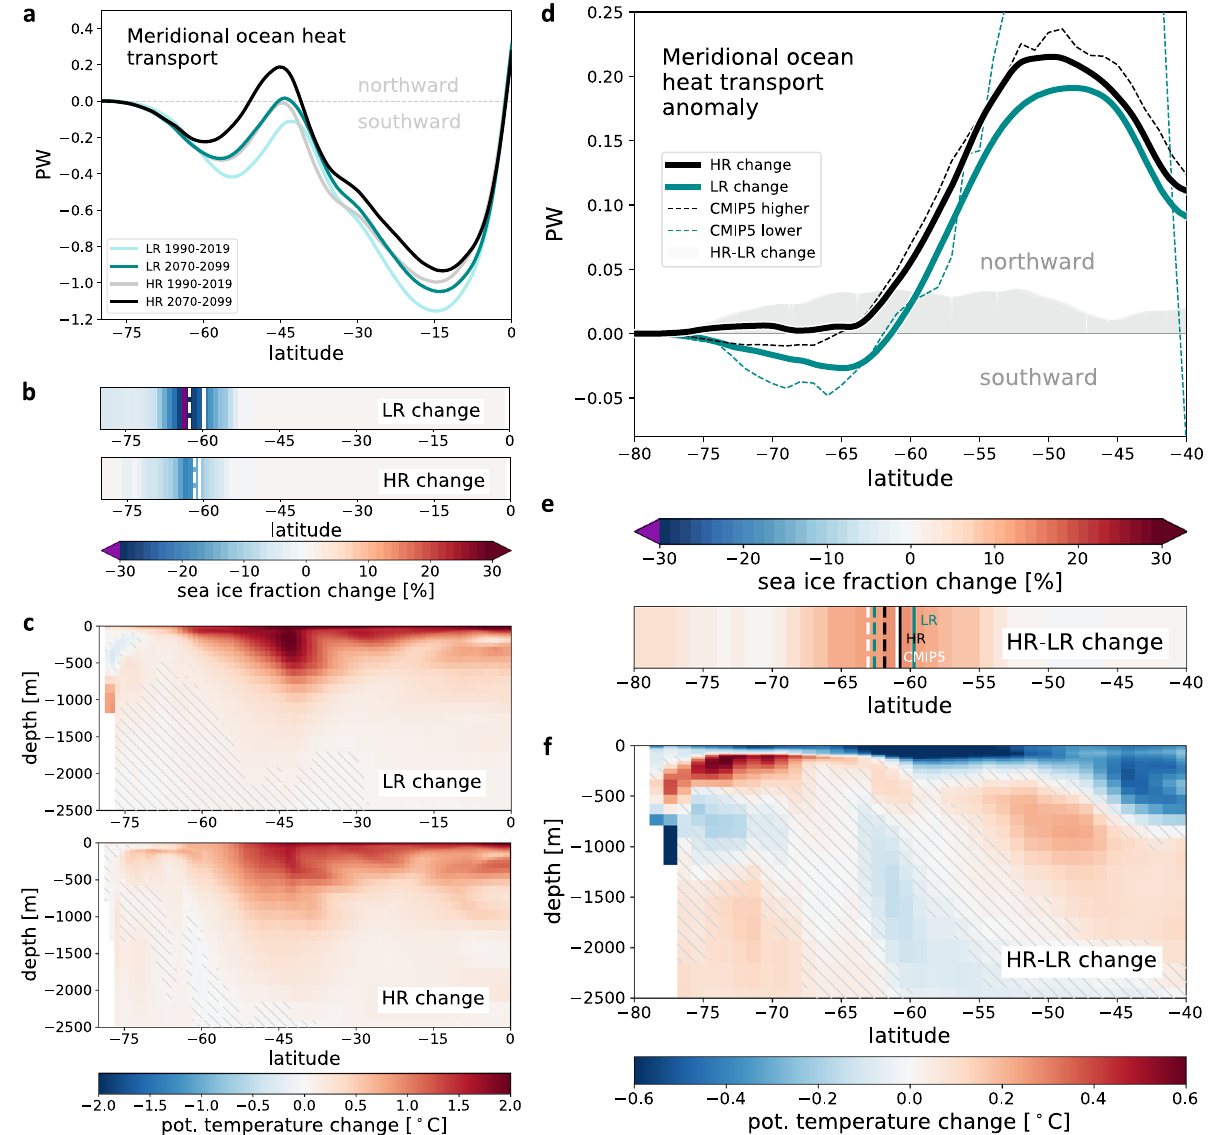
Fig. 5 Meridional ocean heat transport MHT [1 PW = 10 15 W] in the Southern Hemisphere and its link to zonal-mean potential temperature [°C] and zonal-mean sea-ice changes [%]. a MHT in the low-resolution (LR) and high-resolution (HR) experiment for 1990 – 2019 (light green/grey) and 2070 – 2099 (dark green/black). b Zonal-mean sea-ice change and c zonal-mean ocean potential temperature change in LR and HR between 1990 – 2019 and 2070 – 2099. Vertical solid lines in panel ( b ) give the location of the September sea-ice edge in 1990 – 2019, vertical dashed lines the location in 2070 – 2099. d Zoom (40 – 80° S) into the anomalous MHT (2070 – 2099 minus 1990 – 2019). Climate models participating in the Coupled Model Intercomparison Project (CMIP5) are grouped into two sets with ‘ higher ’ / ‘ lower ’ resolution than 90 km (for the computation, see “ Methods ” ). e Difference in the response (HR-LR) of the panels in ( b ). Vertical solid (dashed) lines denote the location of the September sea-ice edge in 1990 – 2019 (2070 – 2099) in LR, HR, and in CMIP5 ( “ Methods ” ). f Difference in the response (HR-LR) of the panels in ( c ). The signals are signi fi cantly larger than typical unforced running 30yr-variability (standard deviation) of zonal-mean potential temperature in the 1950 control simulations. Hatching indicates non-signi fi cant regions where the signals and difference in the response are smaller than two standard deviations (see “ Methods ” ). The “ delta approach ” (see "Methods") has been applied in ( b ) – ( d